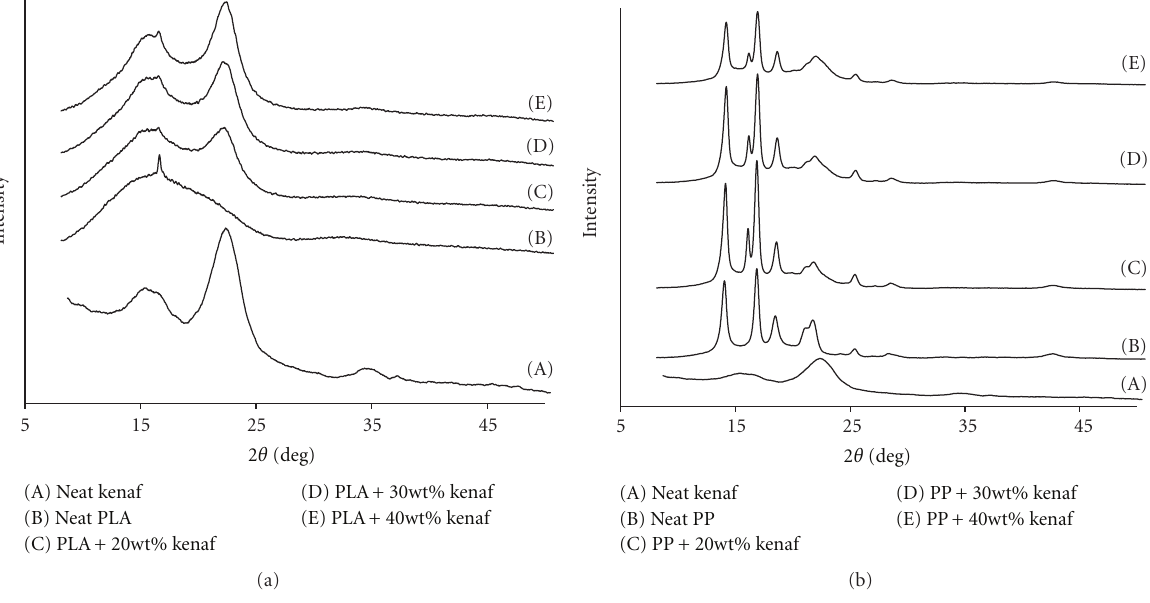
Figure 6: XRD pattern of kenaf fibers and (a) PLA composites and (b) PP